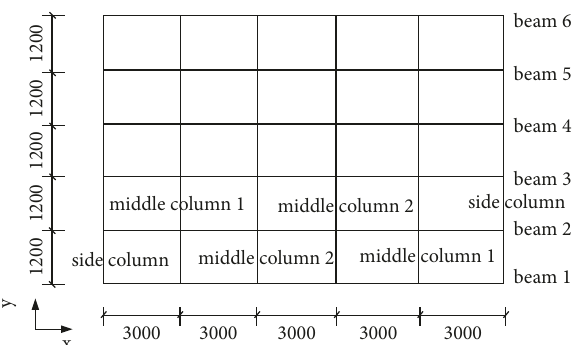
Figure 8: The vertical profile of grille-dam.